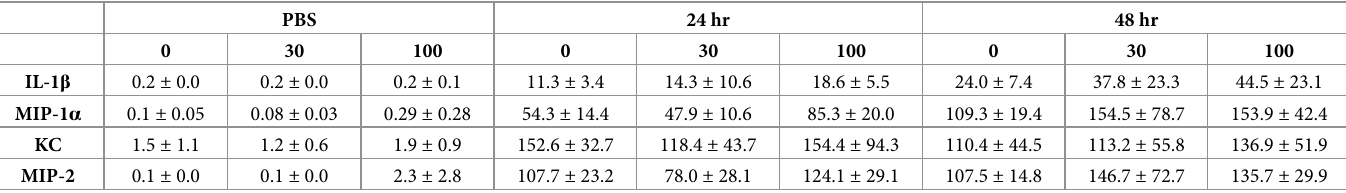
Table 1. BAL cytokine concentration.